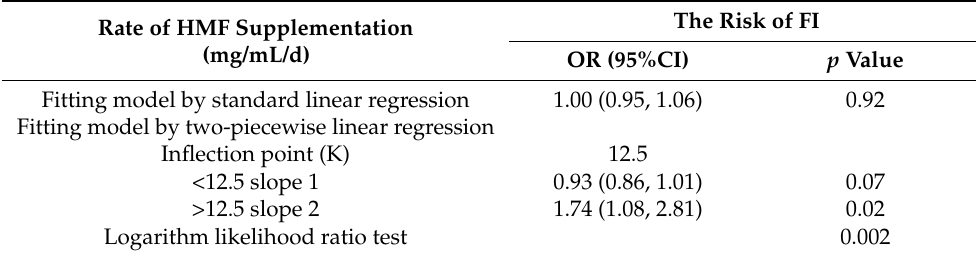
Table 8. Threshold effect analysis of the relationship between rate of HMF supplementation and the risk of FI. Dates, 2015–2018.